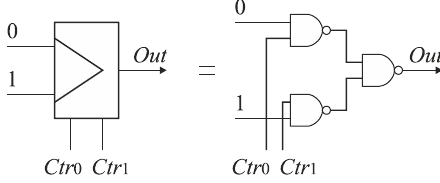
Figure 33. Diagram of symmetrized multiplexer design.